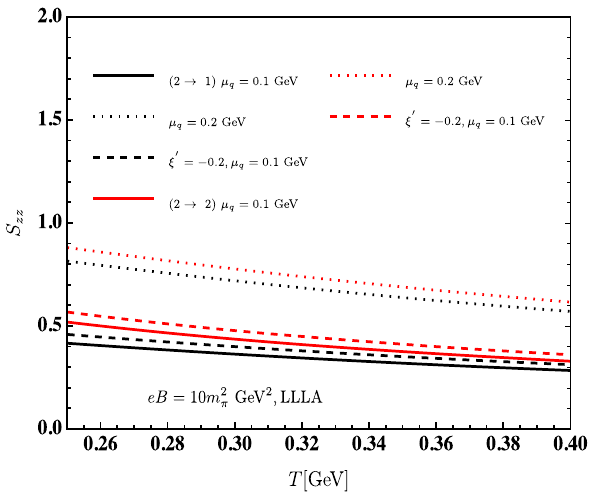
Fig. 6 The temperature dependence of Seebeck coefficient along the direction of magnetic field ( S zz ) for 2 → 1 process (black lines) and 2 → 2 process (red lines) in the LLL approximation. Solid lines and dotted lines represent the calculations of S xx for eB = 10 m 2 π GeV 2 are performed at μ q = 0 . 1 GeV and at 0.2 GeV, respectively. Dashed lines denote the temperature dependence of S xx at μ q = 0 . 2 GeV for eB = 10 m 2 π GeV 2 in an anisotropic medium induced by strong magnetic field (we take ξ (cid:15) = − 0 . 2). Within the assumed regime m 2 q (cid:3) α s , B eB (cid:2) T 2 (cid:2) eB , we artificially take eB = 10 m 2 π GeV 2 and the appropriate temperature can be concentrated within the region 0 . 25 GeV (cid:3) T (cid:3) 0 . 4